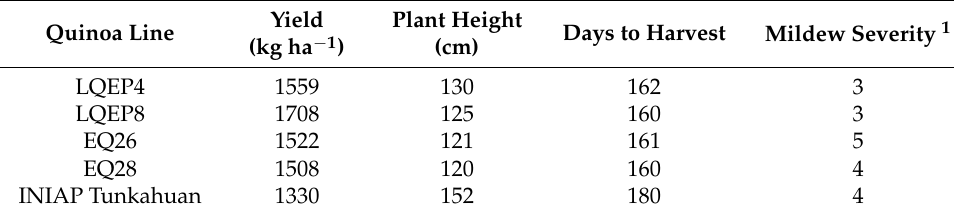
Table 1. Average yield, plant height, days to harvest, and downy mildew severity of four promising quinoa lines evaluated during 2015–2019 in different locations in Ecuador. Yield Plant Height Days to Harvest Mildew Severity 1 Quinoa Line (kg ha − 1 ) (cm) LQEP4 1559 130 162 3 LQEP8 1708 125 160 3 EQ26 1522 121